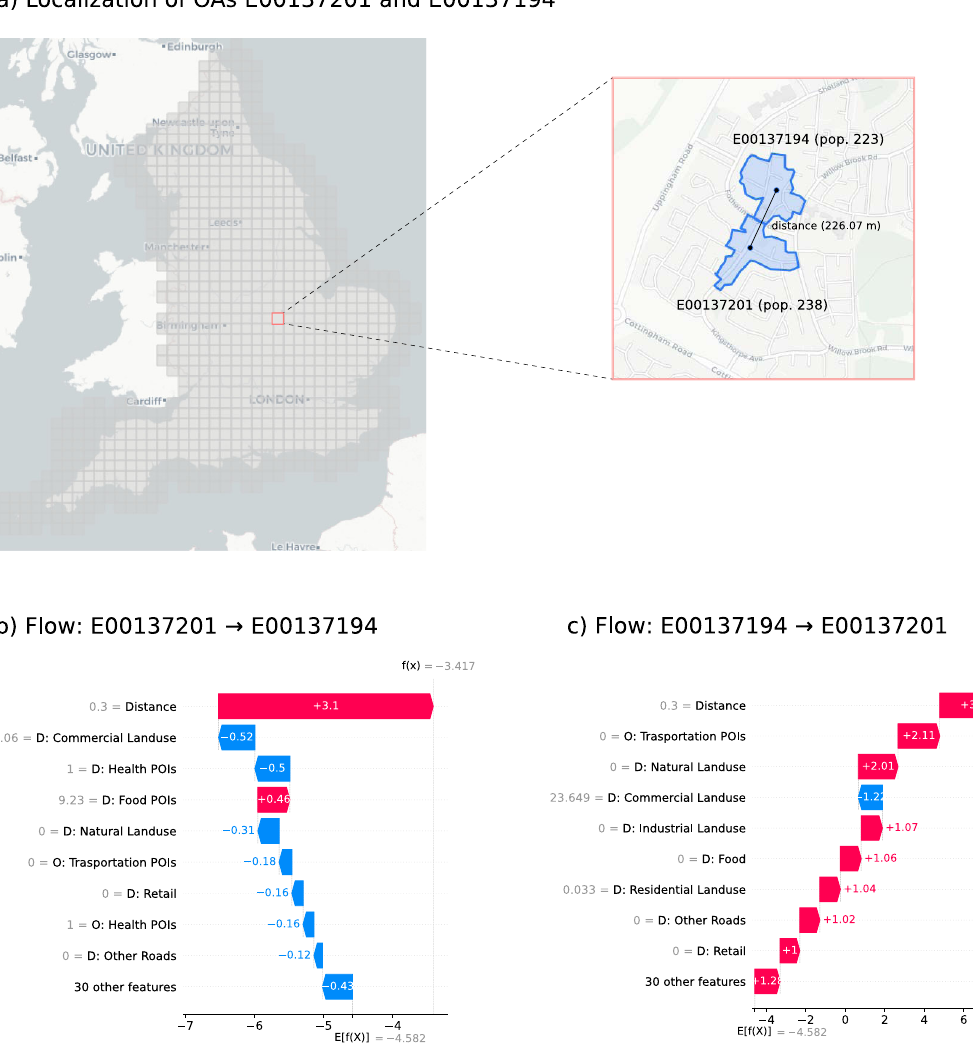
Fig. 6 Explaining generated fl ows. a Geographic position, shape, population, and distance between the Output Areas (OAs) E00137201 and E00137194, situated in Corby, England, a city with more than 50 thousand inhabitants (8th population decile). b , c Shapely values for the two fl ows between E00137201 (population of about 238 individuals) and E00137194 (population of about 223 individuals). Features are reported on the vertical axis, sorted from the most relevant on top to the least relevant on the bottom. The value of the feature is indicated in gray on the left of the feature name. The bars denote the contribution of each feature to the model ’ s prediction (the number inside or near the bar is the Shapely value). The sum of the Shapely values of all features is equal to the model ’ s prediction ( f ( x ) denotes the score): feature with positive (negative) Shapely values push the fl ow probability to higher (lower) values with respect to the model ’ s average prediction E [ f ( x )]. Deep Gravity assigns different probabilities for the two fl ows and the Shapely values indicate that various geographical features are more relevant than the population in this case. The most relevant features for a speci fi c origin-destination pair can differ from the most relevant features